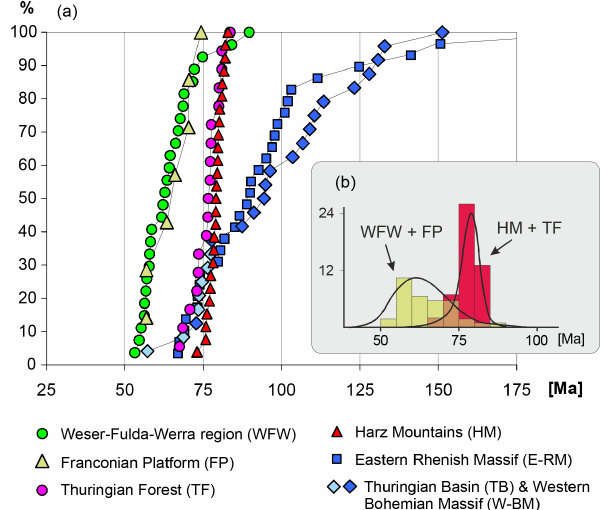
Figure 8. (a) Cumulative distribution of apatite fission-track ages sorted for the individual regions outlined in Fig. 7. Note that the cen- tral Thuringian Basin data (TB) are plotted together with its eastern transition into the Bohemian Massif (W-BM) in a single cumula- tive curve but with a different colour. The Harz Mountains data are taken from von Eynatten et al. (2019), and the Thuringian Forest dataset is composed of our new results and data published by Thom- son and Zeh (2000). (b) Histograms and kernel density estimates (KDEs; Vermeesch, 2012) to emphasize the highly significant con- trast of Werra–Fulda–Weser (WFW) and Franconian platform (FP) data versus Harz Mountains (HM) and Thuringian Forest (TF) data, which differ by 15 to